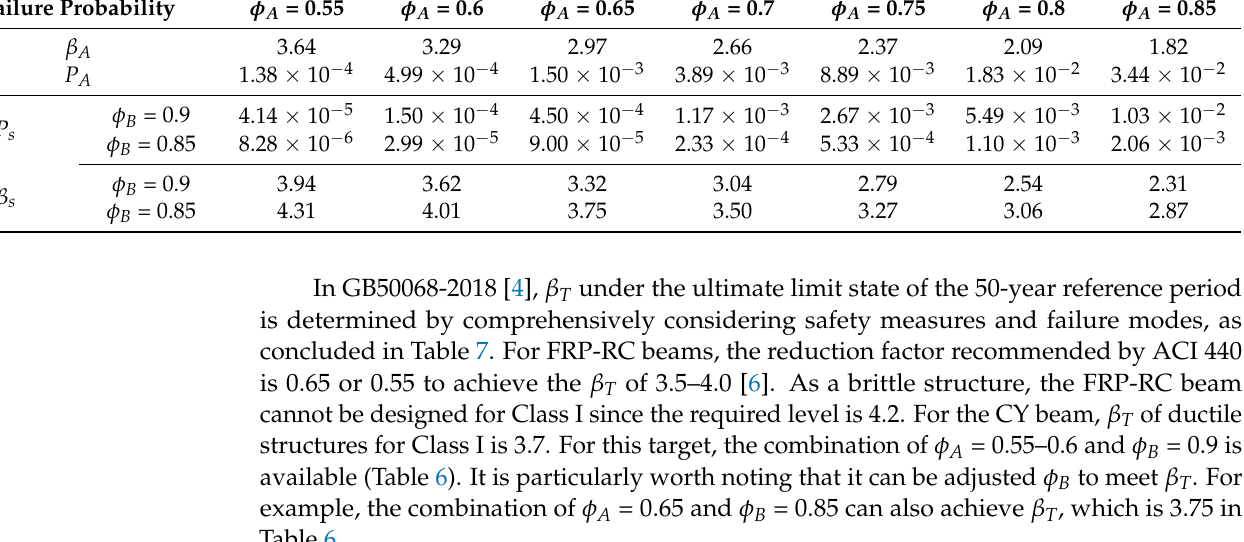
Table 7. Target reliability index β T at the ultimate state of structures under the 50-year period